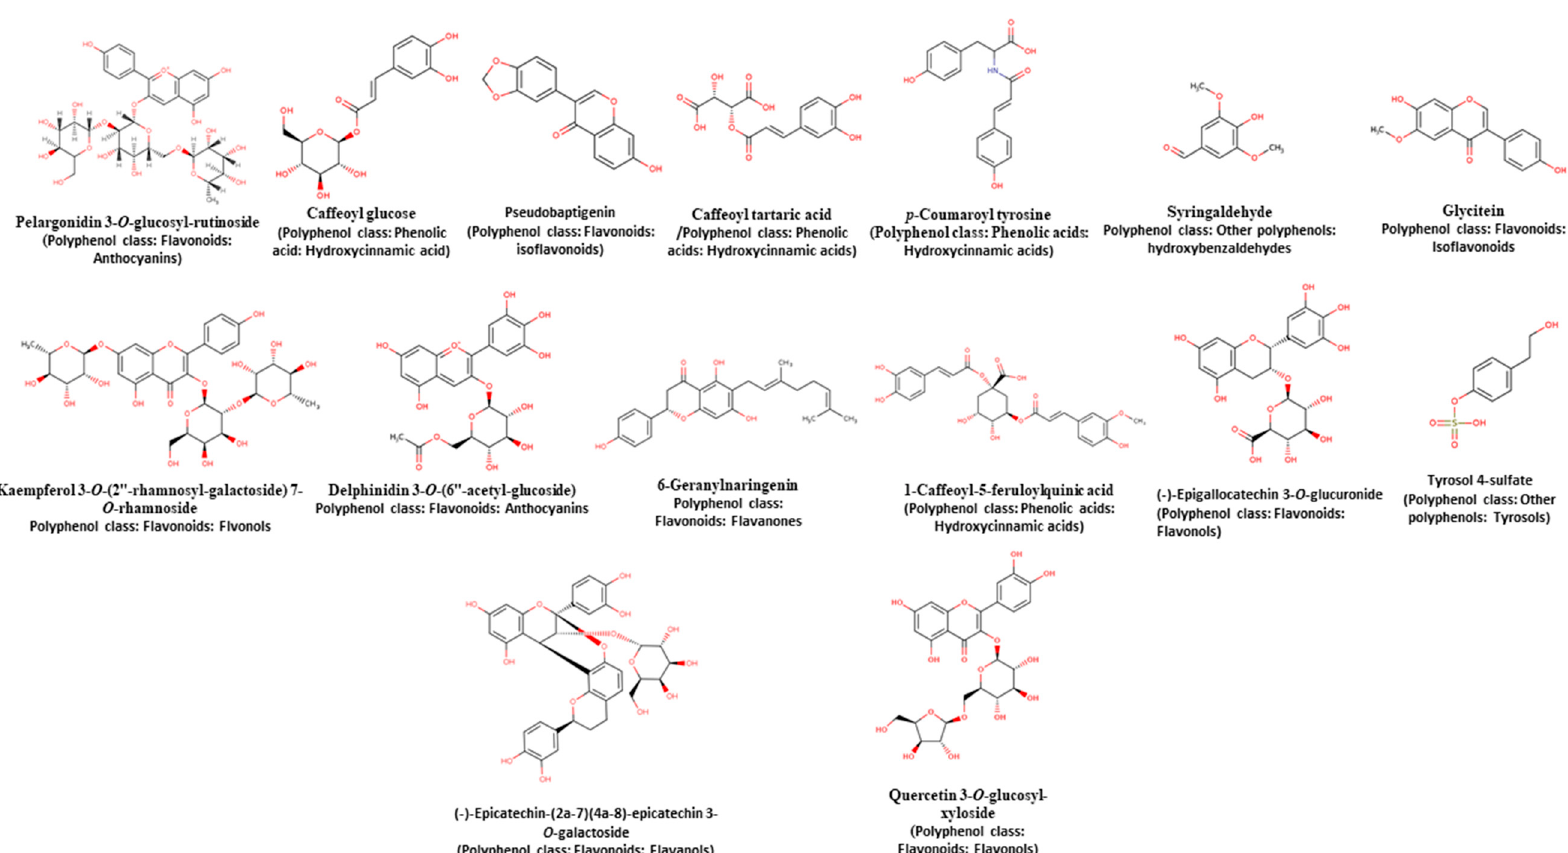
Figure 6. Structures of phenolic compounds from chickpea identified by UPLC-MS in the in vitro gastrointestinal digestion. The images were taken from the database on polyphenol content in foods [53].